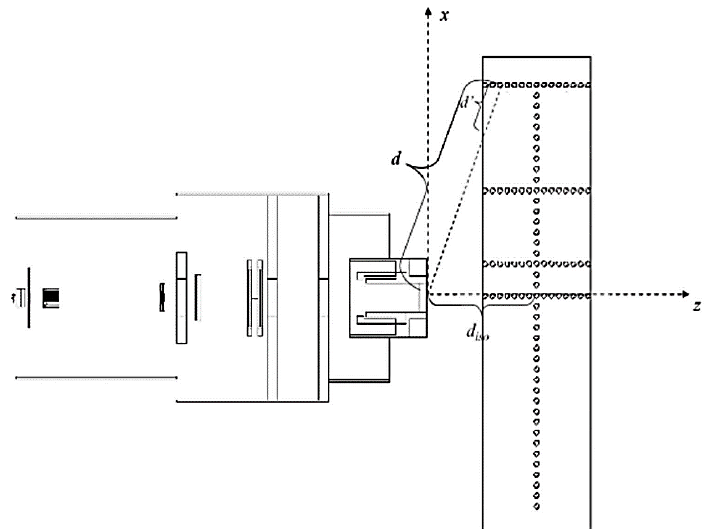
Figure 1. Geometry of a general-purpose proton treatment head and water phantom. Adapted from Perez-Andujar et al.